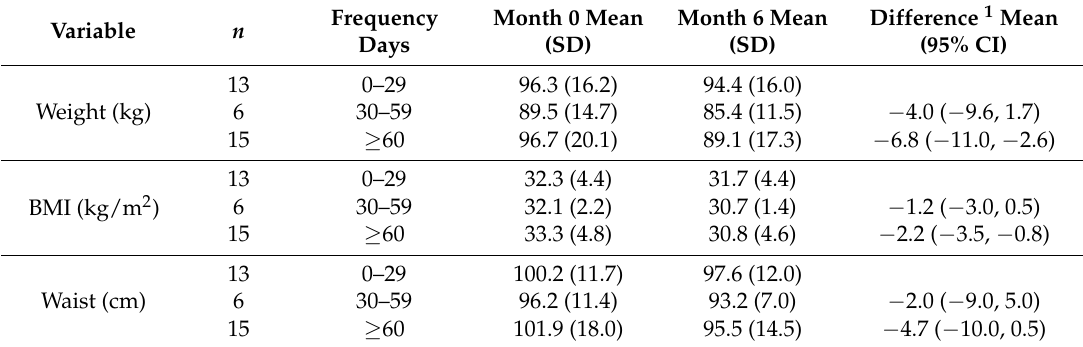
Table 4. Effect of frequency of hunger training on weight, body mass index (BMI), and waist circumference.